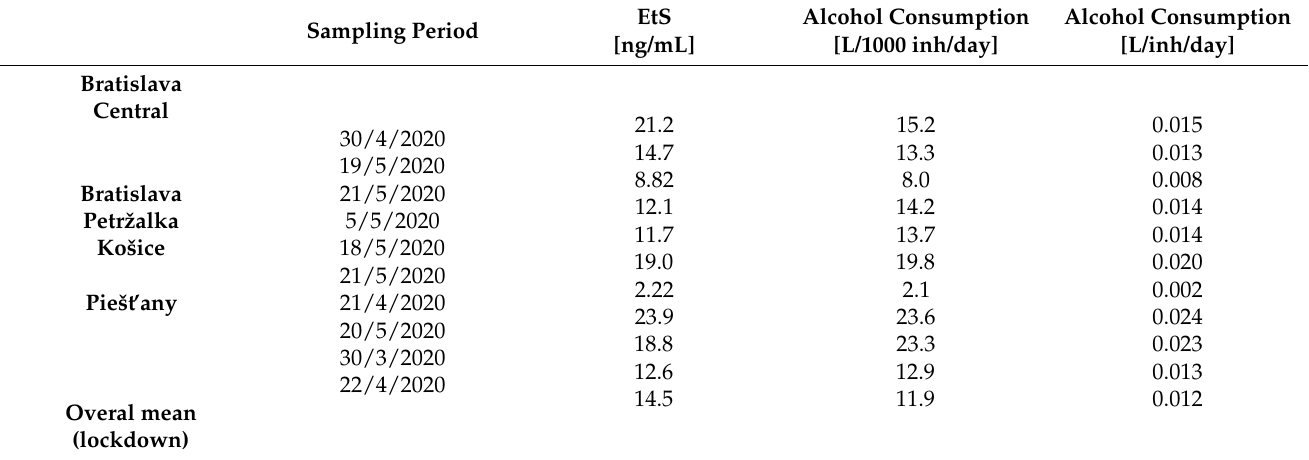
Table 3. Estimated daily consumption of alcohol in three Slovak cities during lockdown in 2020. Sampling